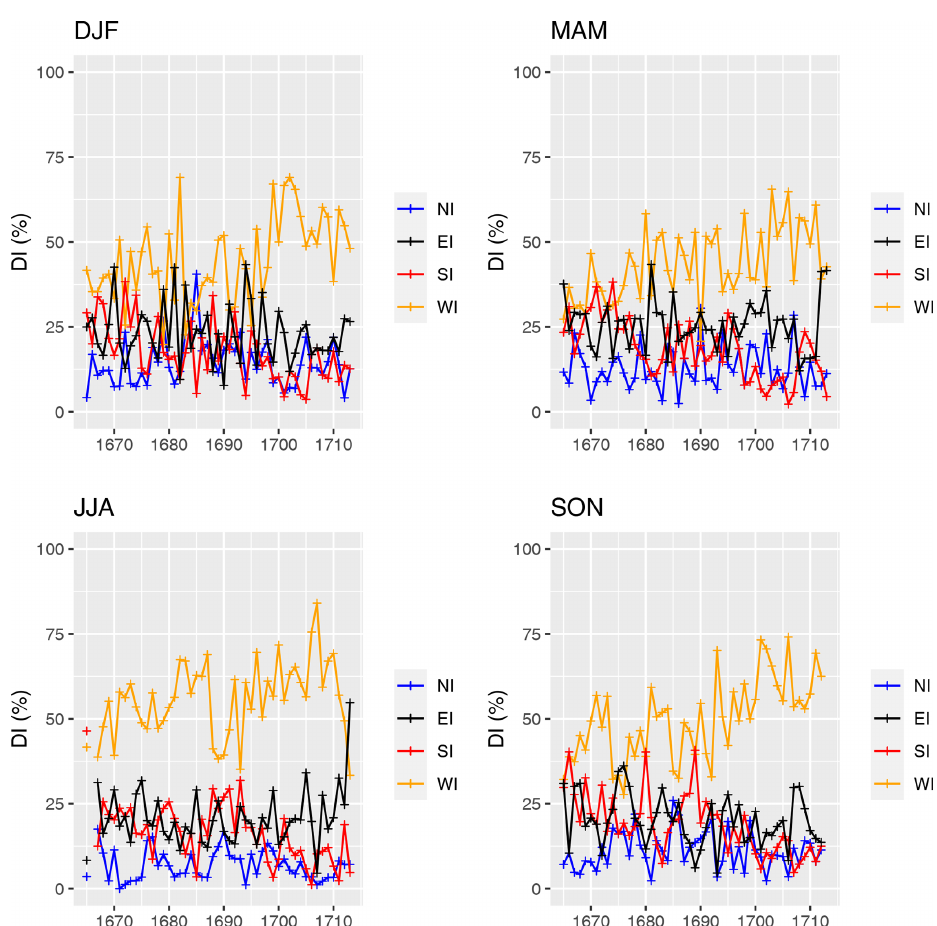
Figure 9. Seasonal time series of the directional indices (DI: NI, EI, SI, WI) in percentage of nonmissing days from 1665 to 1713. The individual points indicate the mean per season of the direction of the movement of the